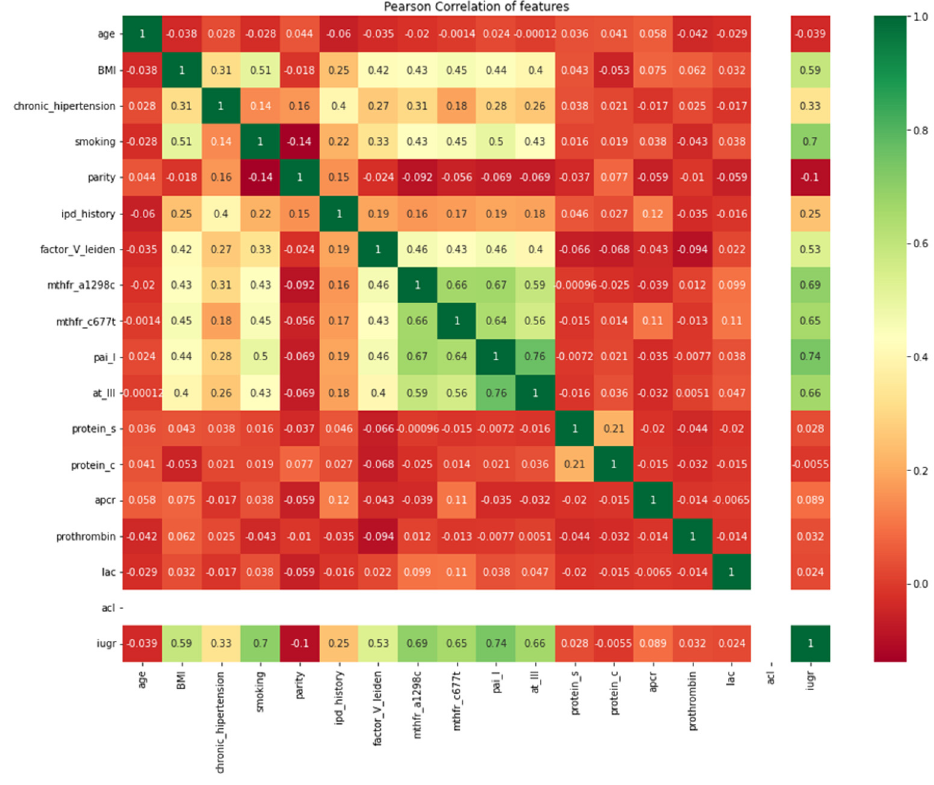
Figure 5. Graphic representation of the Pearson correlation matrix for the included predictors.